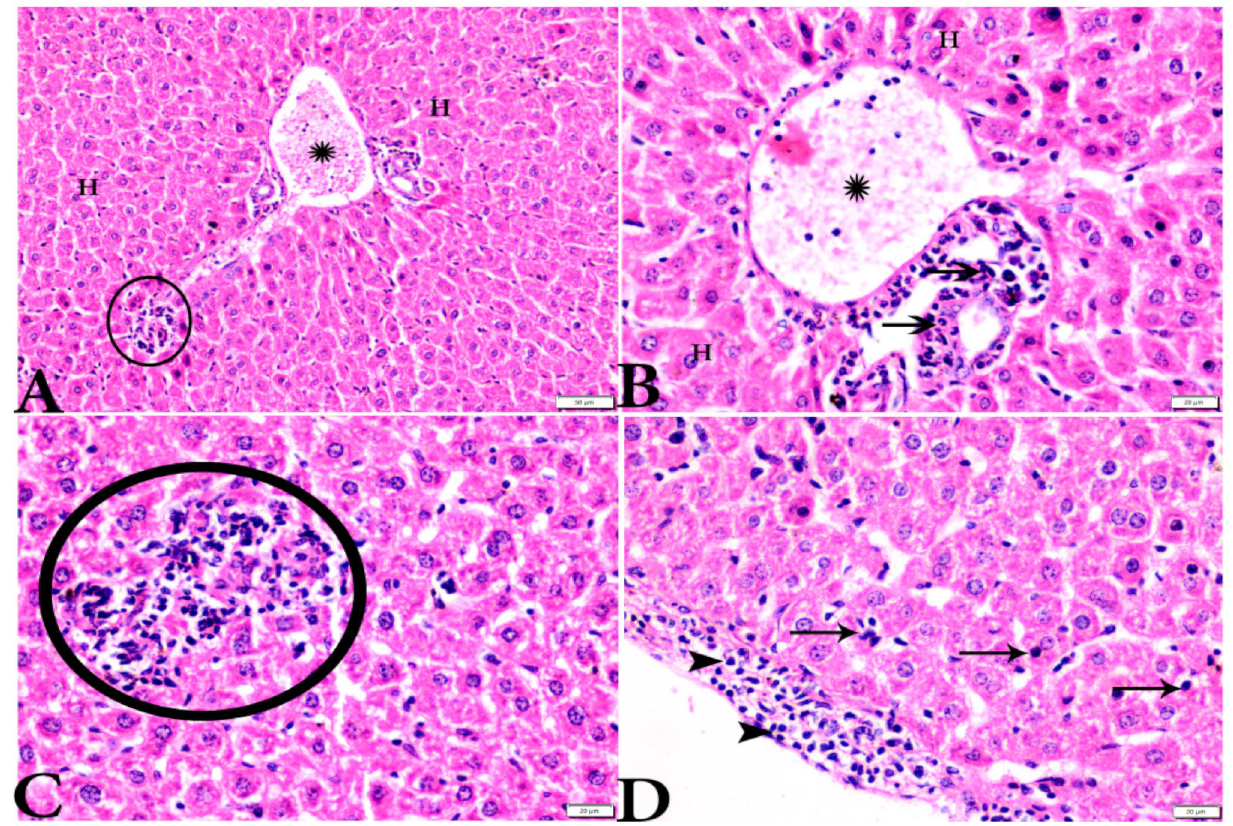
Figure 4. Photomicrograph of H&E-stained liver tissue sections from Toxoplasma gondii -infected animals treated with propolis (G3) showing: ( A , B ): severe vascular congestion in the portal vein (P.V) infiltrated with inflammatory cells (stars), more or less normal hepatocytes (H); and ( B ): aggregated bradyzoites (arrows) at portal area. ( A , C ): Focal area of mononuclear cellular infiltration (circles). ( D ): Multiple bradyzoites present in Gilson capsule (arrowheads) and bradyzoites in hepatocytes (arrows). The scale bar is provided below each image.